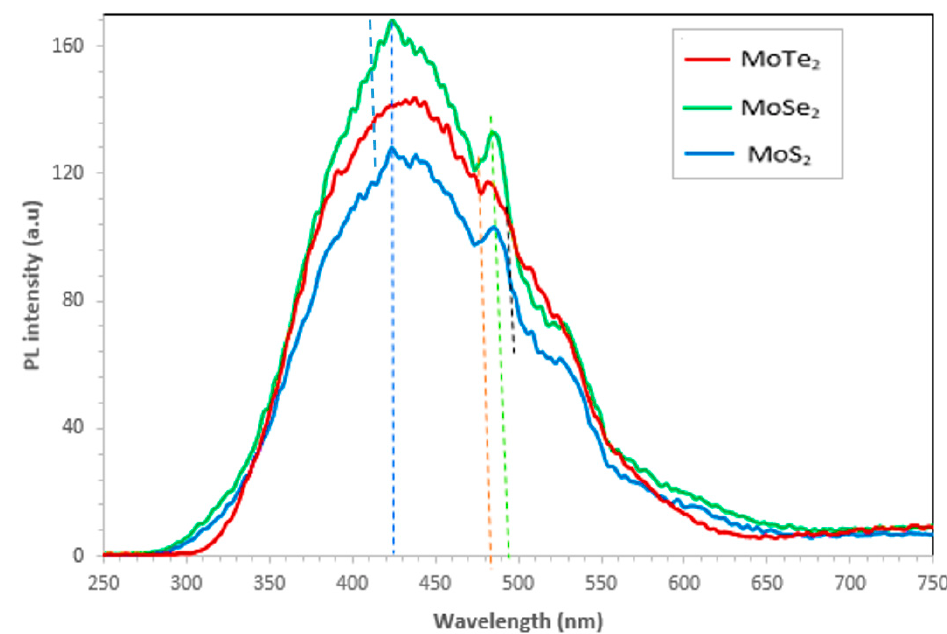
Figure 4. Emission spectra of the MoX 2 (X = S, Se, Te) nanoparticles.